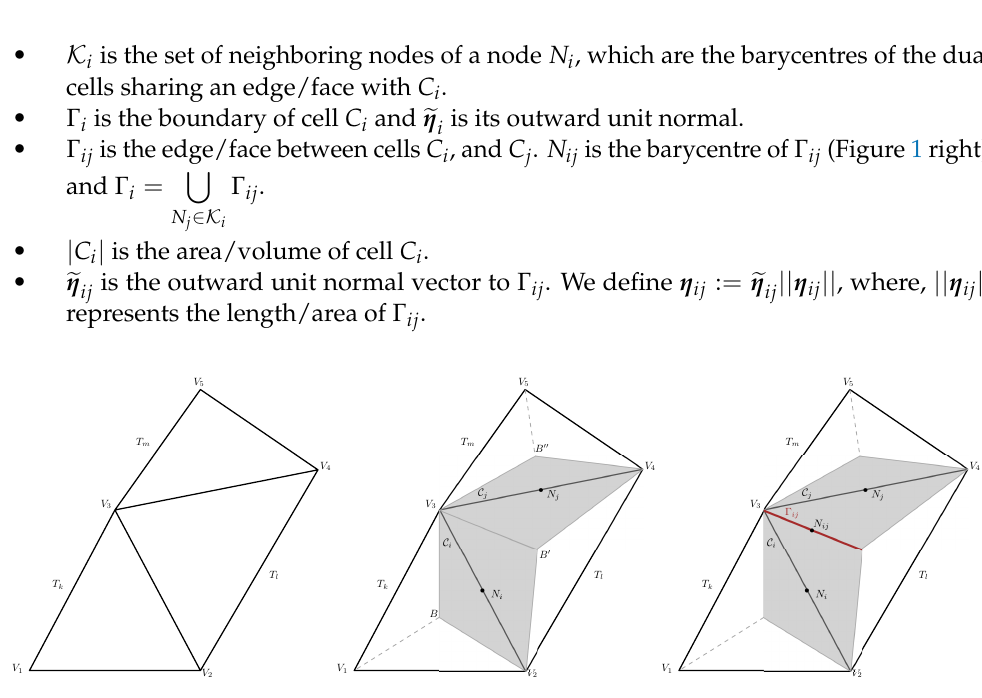
Figure 1. Construction of face-type dual elements from a 2D triangular mesh. ( Left ): primal elements T k , T l , T m with vertex V n , n = 1, . . . ,5. ( Center ): dual interior cells C i , C j (shadowed in grey); white triangles correspond to boundary cells. ( Right ): boundary face, Γ ij (highlighted in red), between the dual elements C i and C j .